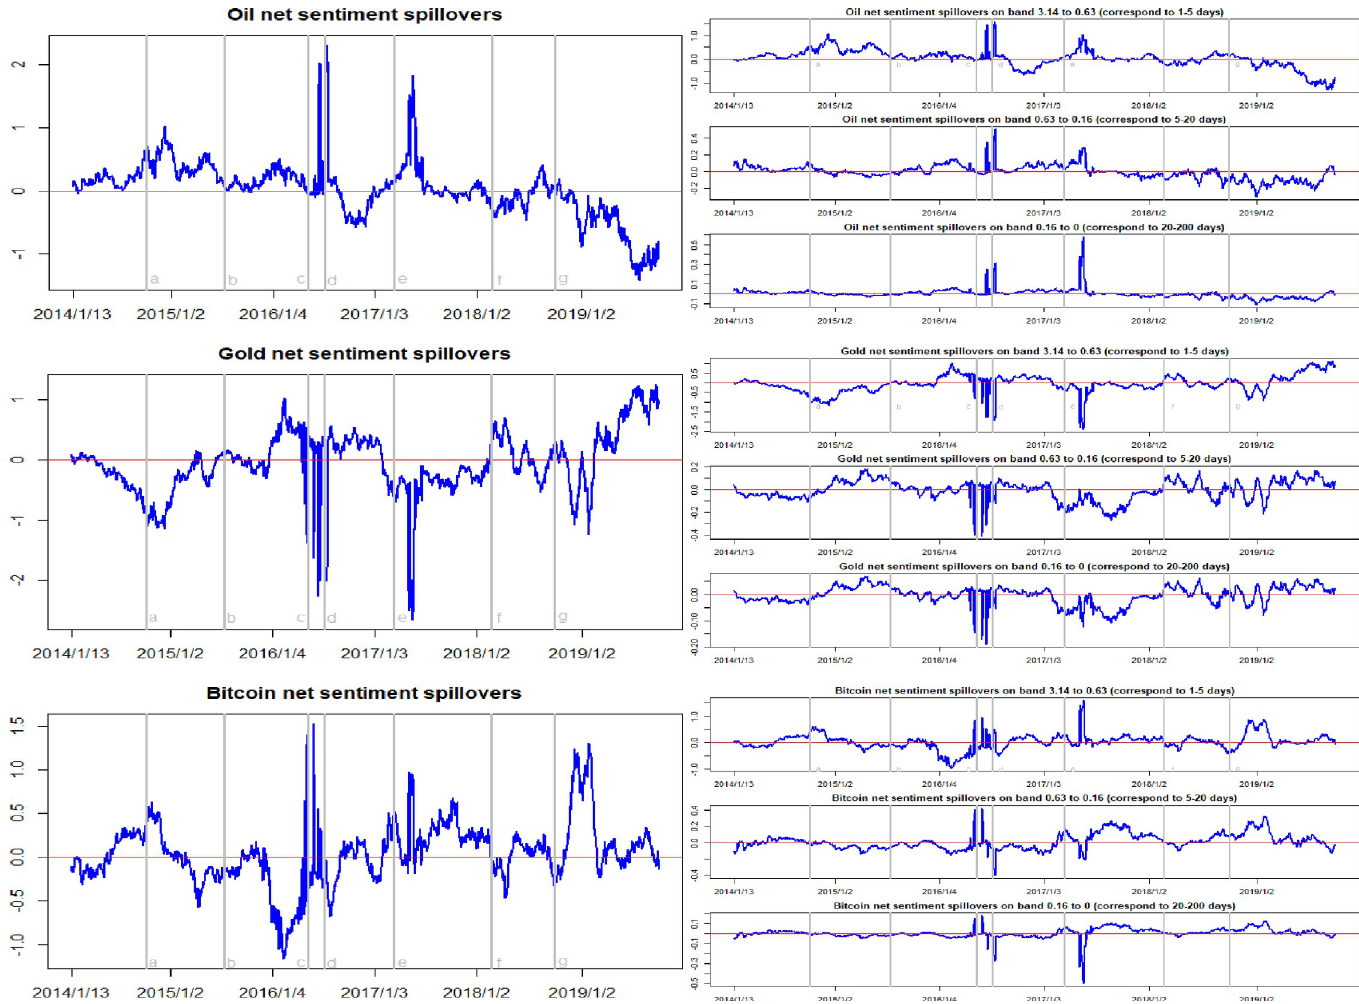
Fig 3. Time-frequency dynamics of net sentiment spillovers for oil, gold, and Bitcoin. a, b, c, d, e, f, g respectively represent the seven events: the WTI oil price collapsed in October 2014, the black swan event in gold market occurred in July 2015, the sharp rise of bitcoin prices in May 2016, the Brexit event in July 2016, the expectations of a Federal Reserve rate hike in March 2017, the price of Bitcoin and gold fluctuating fall at the beginning of 2018, and the WTI oil price declines in August 2018.